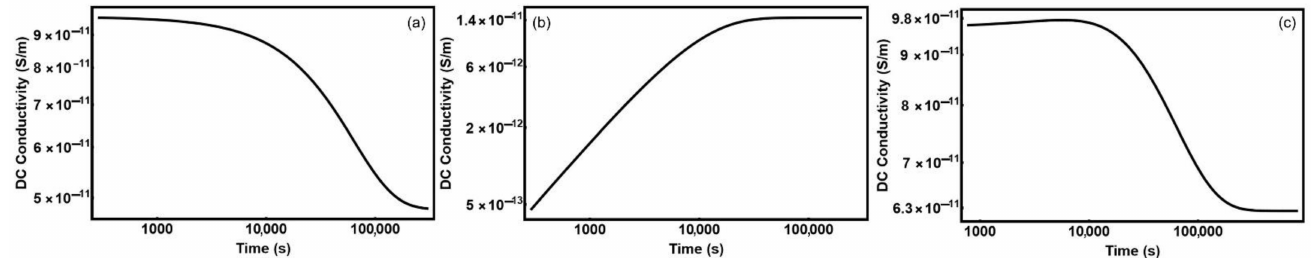
Figure 4. Time-dependent DC conductivity of liquid crystal cells. The cell thickness is 50 µ m. ( a ) Time dependence of DC conductivity caused by the ion-capturing effect (ions already present in liquid crystals are captured by the substrates of the cell). ( b ) Time dependence of DC conductivity due to the ion-releasing effect (ionic contaminants originated from contaminated substrates of the cell enrich liquid crystals with ions). ( c ) Time dependence of DC conductivity caused by the combination of the ion-capturing and ion-releasing processes shown in ( a , b